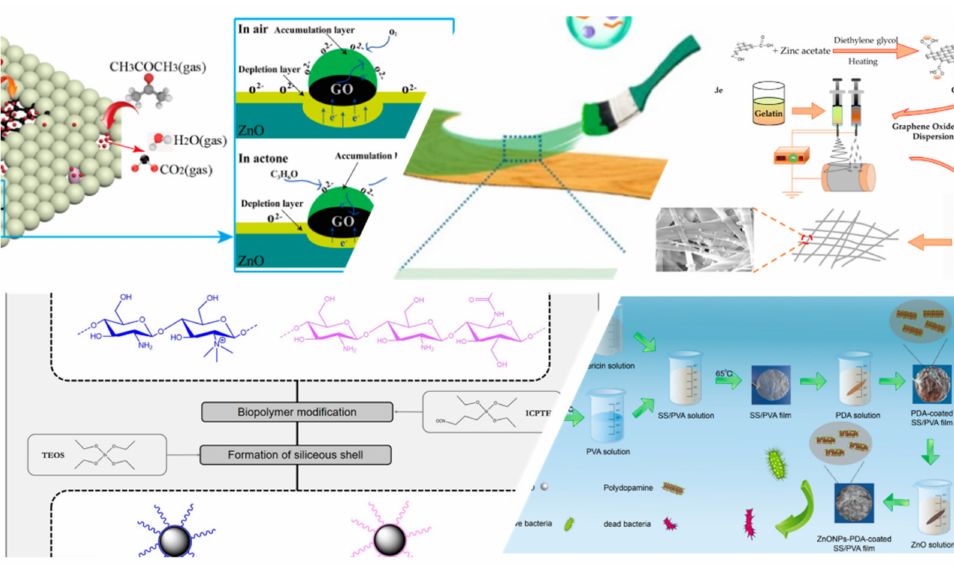
Figure 1. An overview of the editorial’s